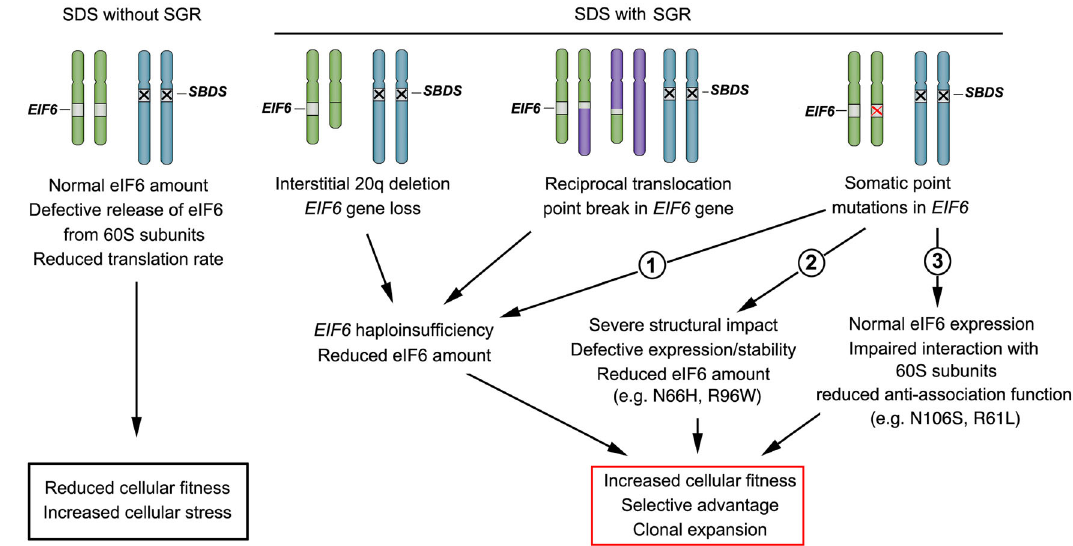
Fig. 8 Schematic representation of EIF6 somatic genetic rescue (SGR) mechanisms in SDS. Chromosomal alterations (interstitial 20q deletion, reciprocal translocation), somatic nonsense or small indel mutations may cause EIF6 hapoinsuf fi ciency (denoted 1); other EIF6 somatic point mutations may reduce eIF6 protein expression/stability (denoted 2) or impair the interaction of eIF6 with 60S subunits (denoted